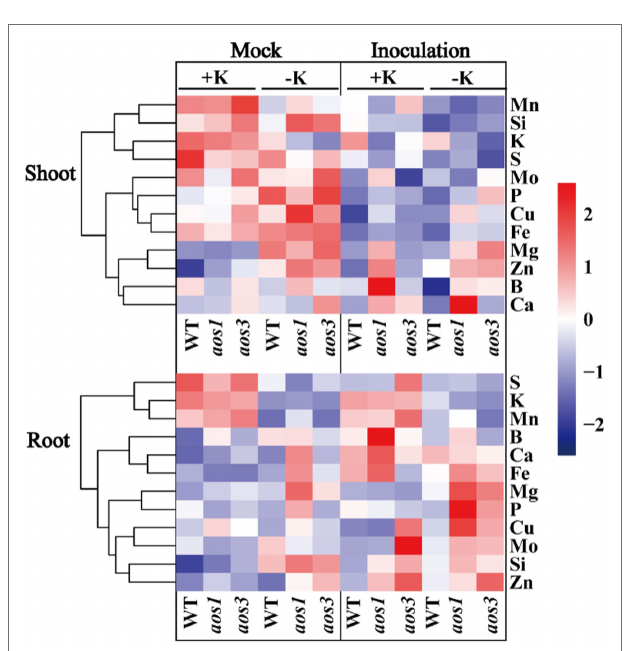
FIGURE 7 | Effects of S. oryzae infection on nutrients uptake in rice.